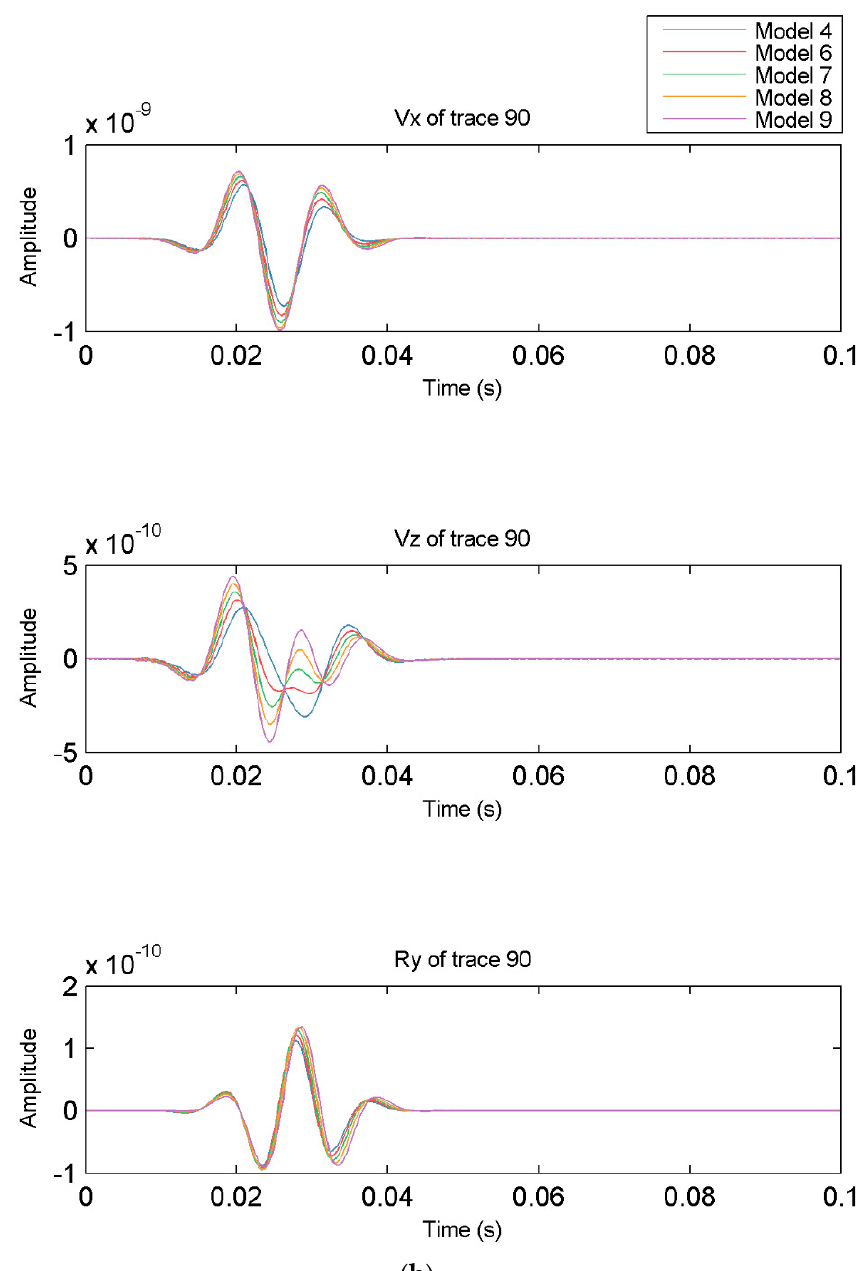
Figure 9. Influence of δ on seismic records generated from the expansion source: ( a ) the seismic records of the 30th trace; ( b ) the seismic records of the 90th trace.